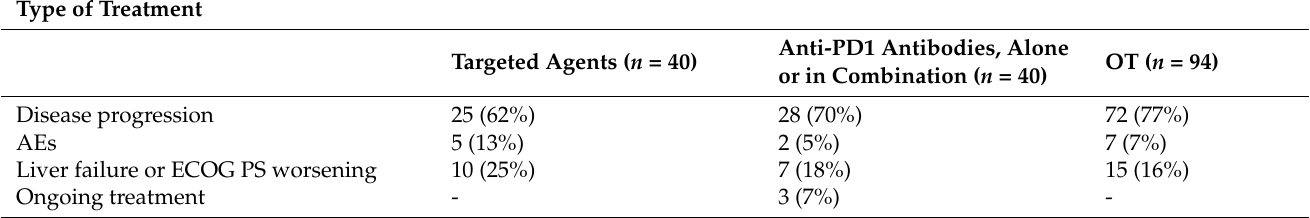
Table 5. Reasons for second-line treatment discontinuation.